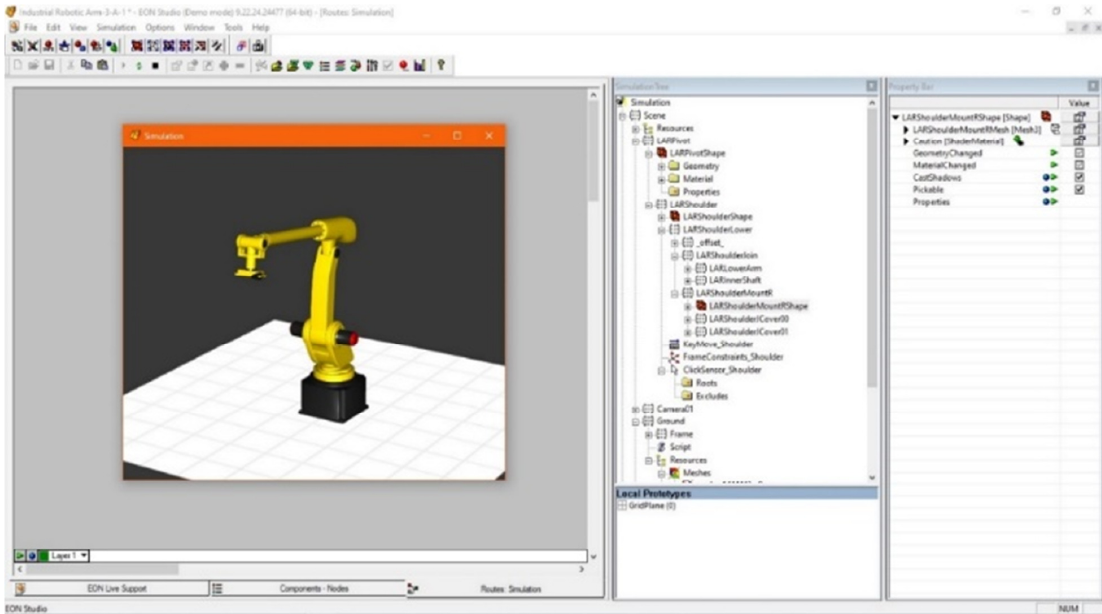
Fig. 5. CAD Model Imported into